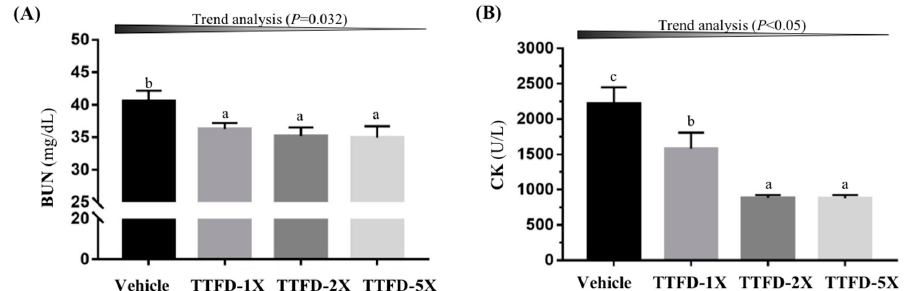
Figure 5. Effect of 4-week TTFD supplementation on the serum BUN ( A ) and CK ( B ) levels after extended exercise challenge. The indicated four groups underwent 90 min swimming exercise and blood was sampled after 60 min rest. Data are mean ± SEM for n = 10 mice per group and the columns with different letters (a, b) are significantly different at P < 0.05.